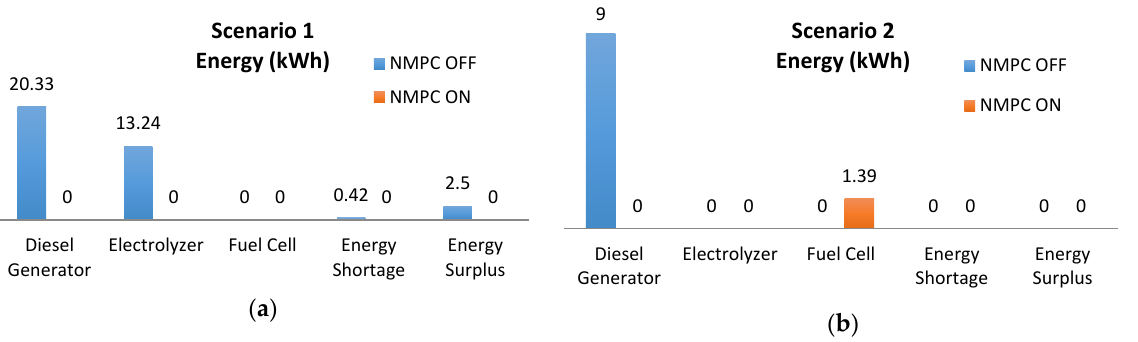
Figure 22. Comparative results in energy management: ( a ) Daily operation; ( b ) Daily operation with disturbance.